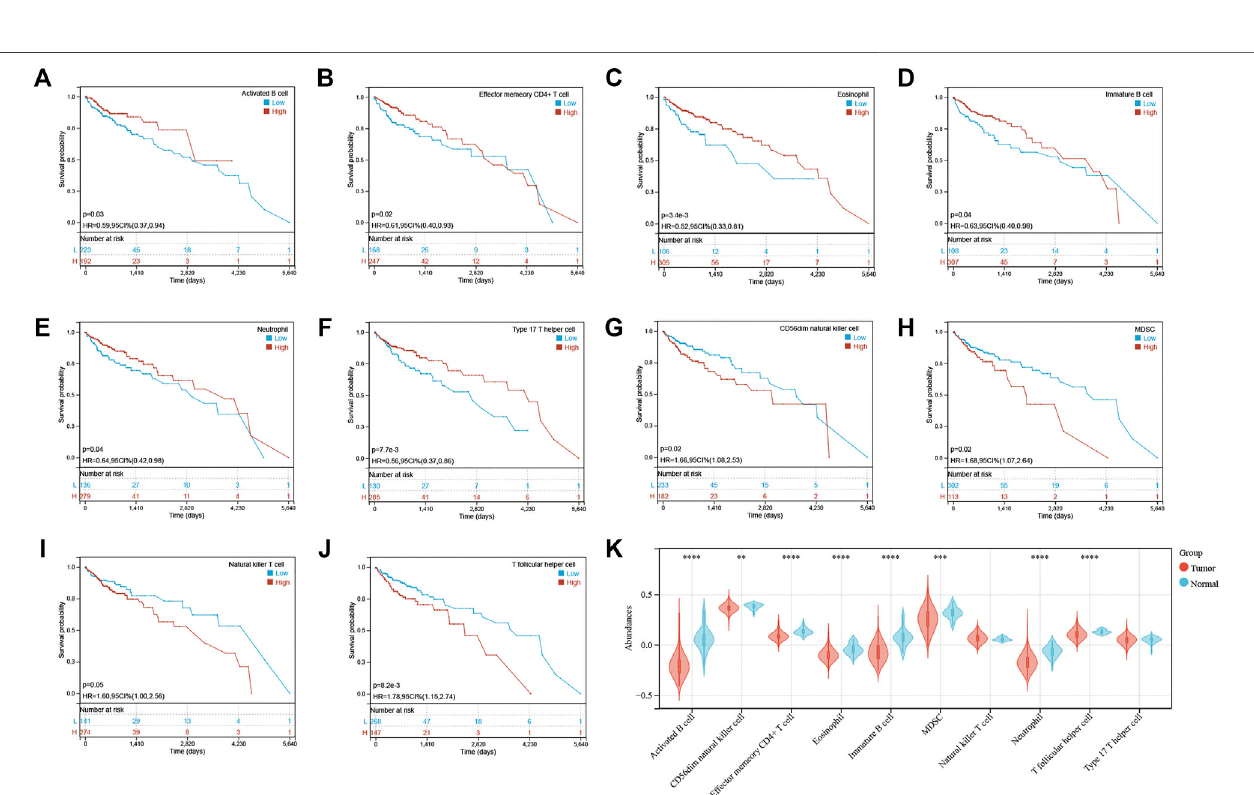
FIGURE3|(A – J) Kaplan – Meiersurvivalcurves ofindividualcelltypes withsigni fi cantprognosticvalues. (K) Differences inabundanceof10immunecellsbetween normal and tumor tissues. (L) Immune cell abundances estimated by fi ve algorithms (CIBERSORT, EPIC, IPS, MCPcounter, and TIMER) between two clusters.